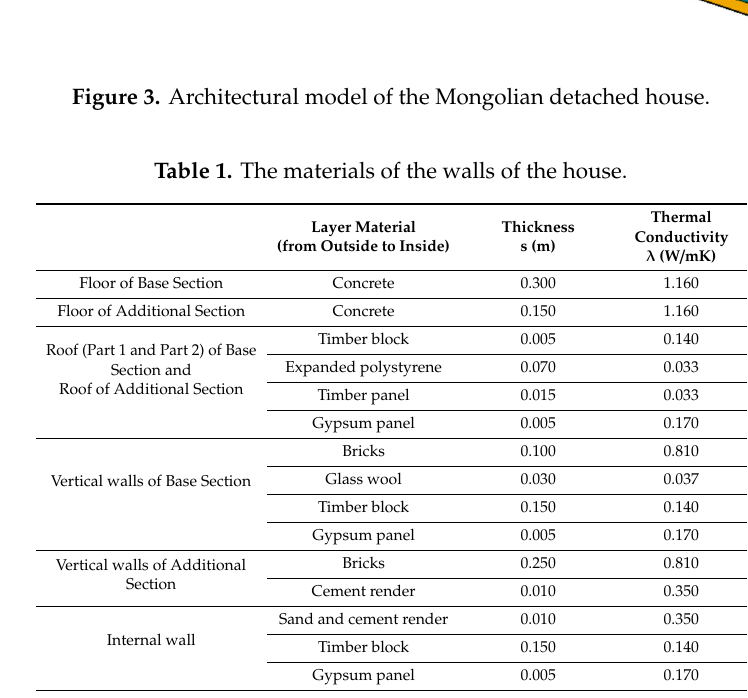
Table 2. The characteristics of the walls of the